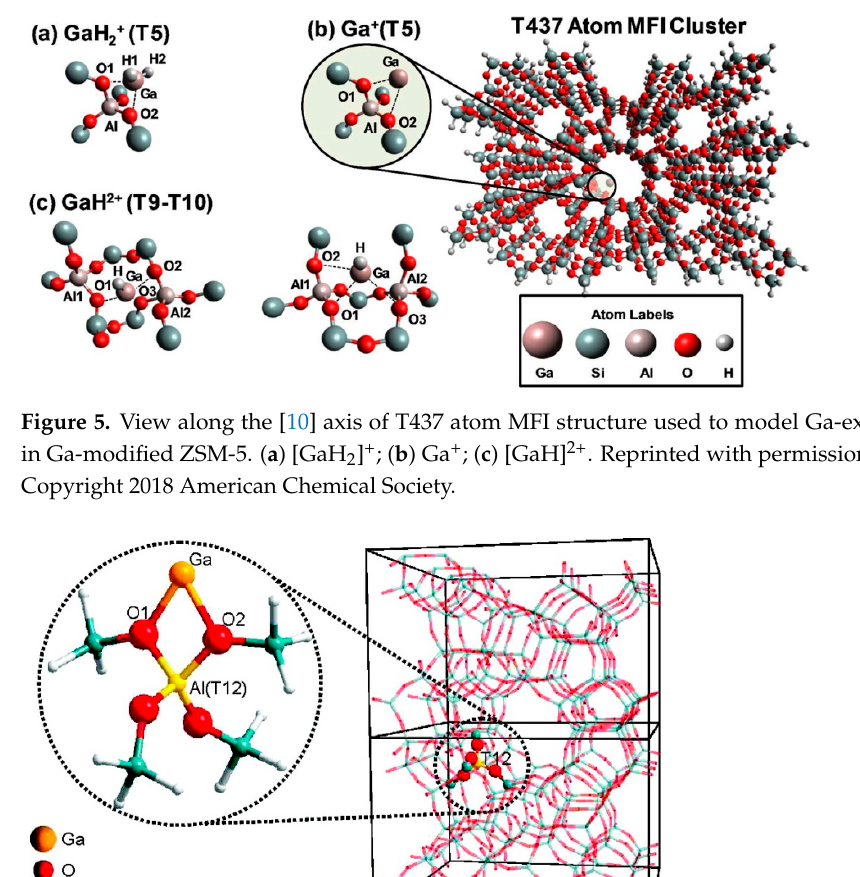
Figure 4. H 2 -TPR profiles of Ga/ZSM-5 prepared via different methods. Reprinted with permission from ref [46]. Copyright 2019 American Chemical Society.